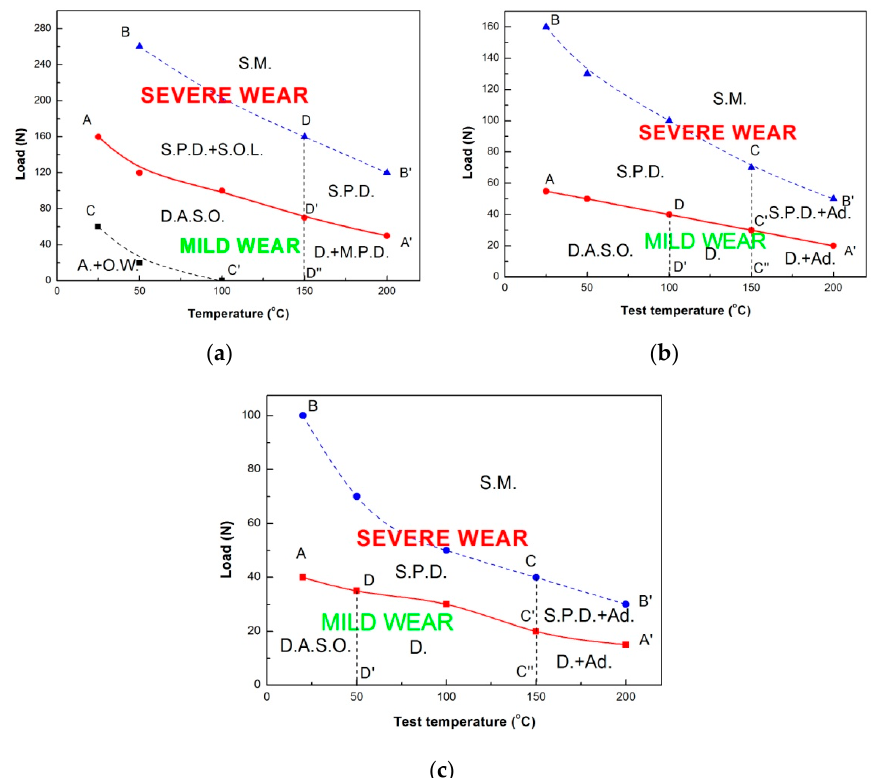
Figure 5. The elevated-temperature wear transition maps: ( a ) 0.8 m/s, ( b ) 3.0 m/s, ( c ) 4.0 m/s. A.—Abrasion; Ad.—Adhesion; O.W.—Oxidative Wear; D.—Delamination; D.A.S.O.—Delamination Accompanied by Surface Oxidation; M.P.D.—Mild Plastic Deformation; S.P.D.—Severe Plastic Deformation; S.O.L.—Spallation of Oxide Layer; S.M.—Surface Melting.